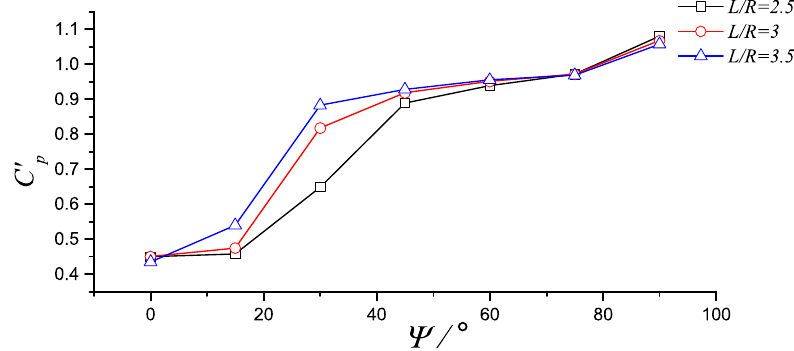
Figure 15 . Influence of deflection angle on hydrodynamic characteristics of hydraulic turbine where Z = 2.